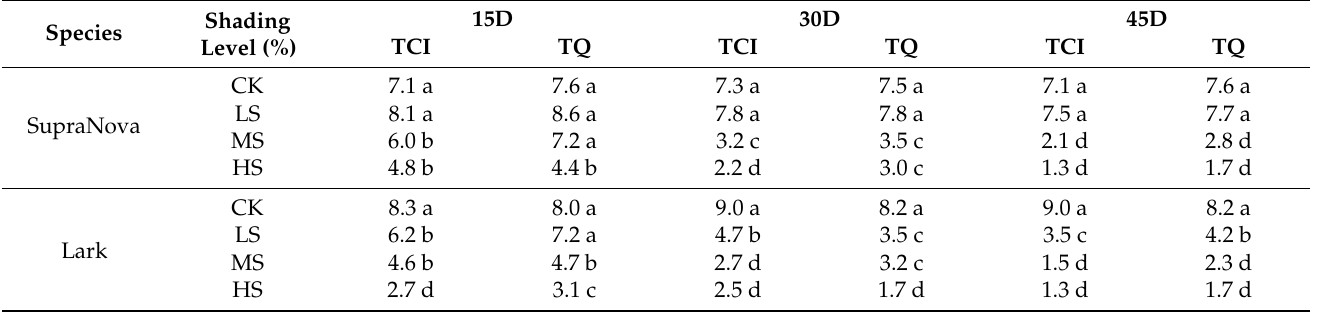
Table 1. Effects of shade on turf quality (TQ) and turf color intensity (TCI) of two turfgrass species.